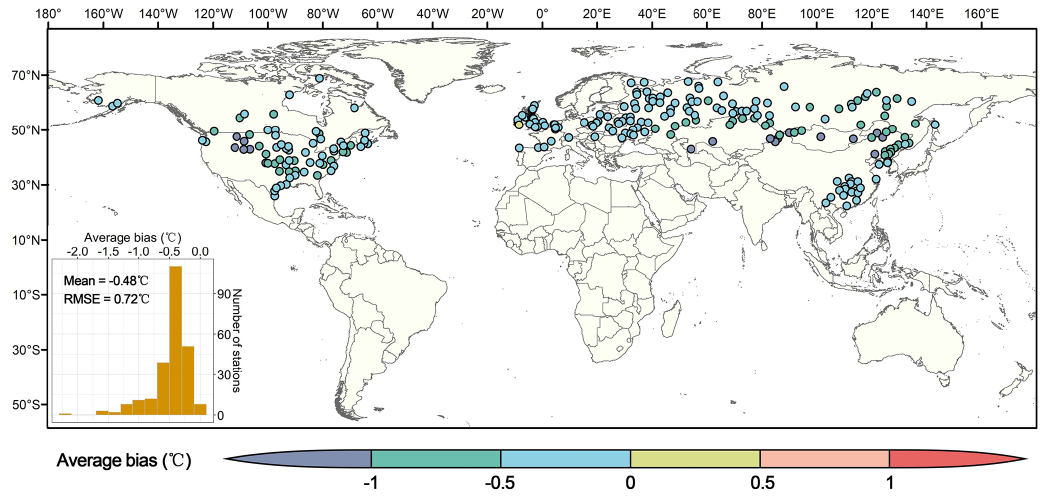
Figure 6. Average bias between daily maximum T W of GSDM-WBT and